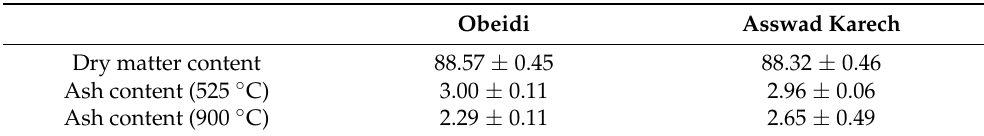
Table 1. Dry matter and ash content (% w / w ) of grape seeds from pomace of Obeidi and Ass- wad